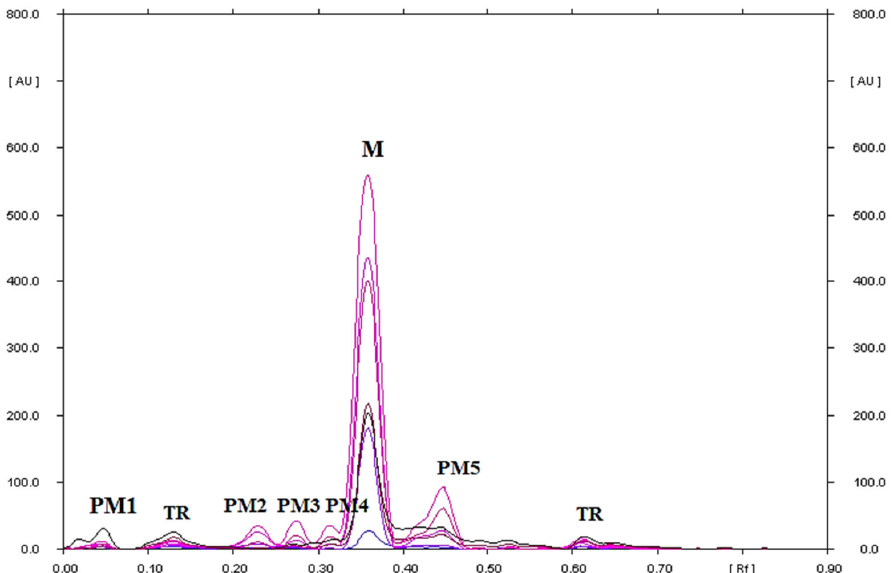
Figure 7. TLC-UV densitograms recorded in the multi wavelength from 200 to 380 nm (at wavelength intervals of 30 nm at each step) of metronidazole in hydrogen peroxide (3%) solution, which after heating at 40 ◦ C for 1000 h was separated on silica gel using a mobile phase chloroform–methanol (9:1, v / v ), where M is metronidazole, PM1, PM2, PM3, PM4, and PM5 are the degradation products of metronidazole , and TR is the traces.